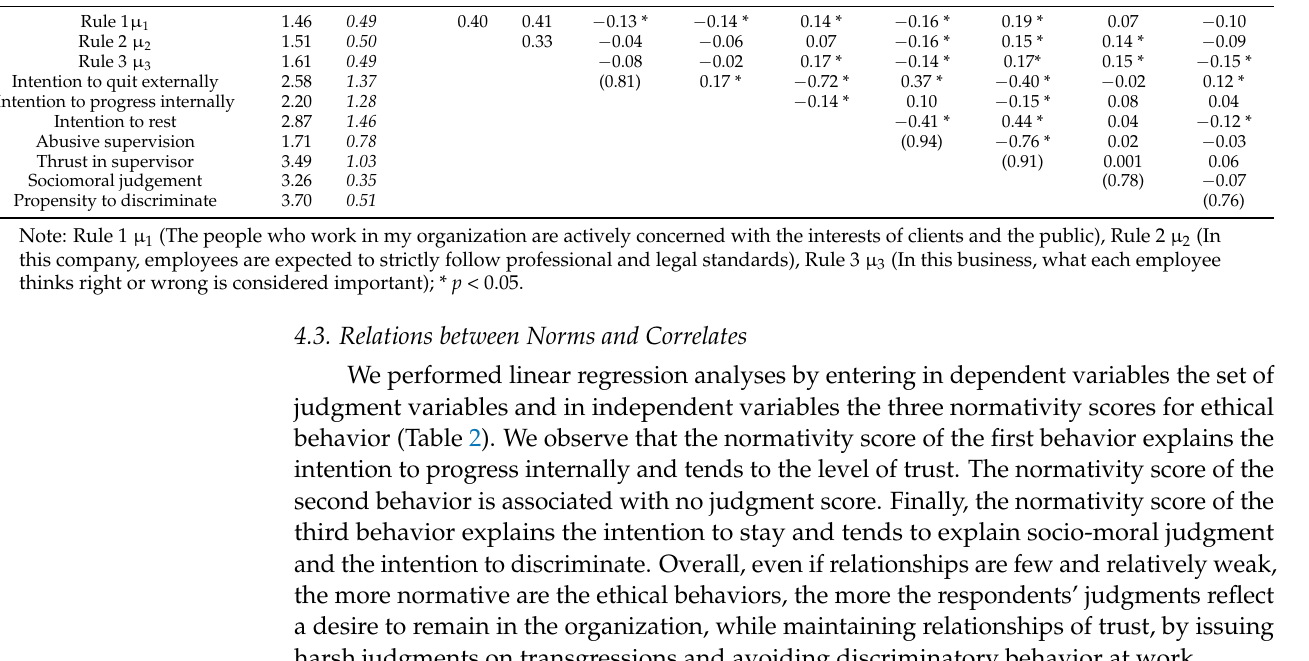
Table 2. Regression analyzes—norms in independent variables and correlates of judgment in dependent variables. Intention to Quit Externally Norm